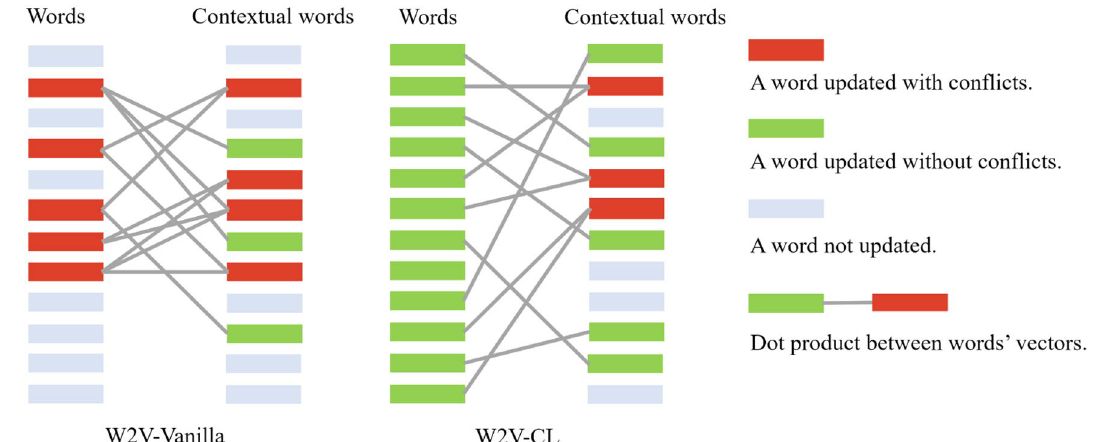
Fig. 7 Illustration of updating conflicts on W2V-Vanilla model and W2V-CL model. Conflicts happen when a vector involves in 2 or more